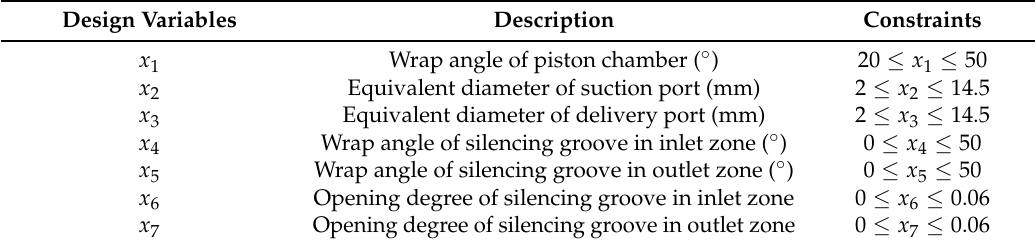
Figure 6. MDO procedure for the pump.